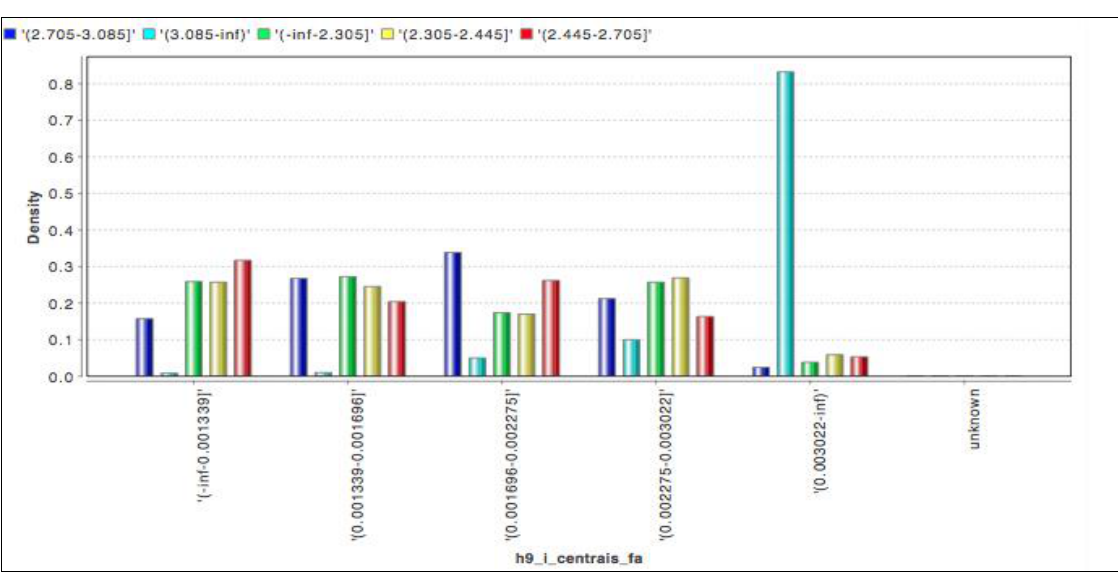
Figura 7. Densidad de probabilidad de intervalos discretos de THDv con relación a la corriente del 9º armónico. La figura 8 muestra la densidad de probabilidad de ocurrencia de cinco intervalos discretos de THDv en relación con